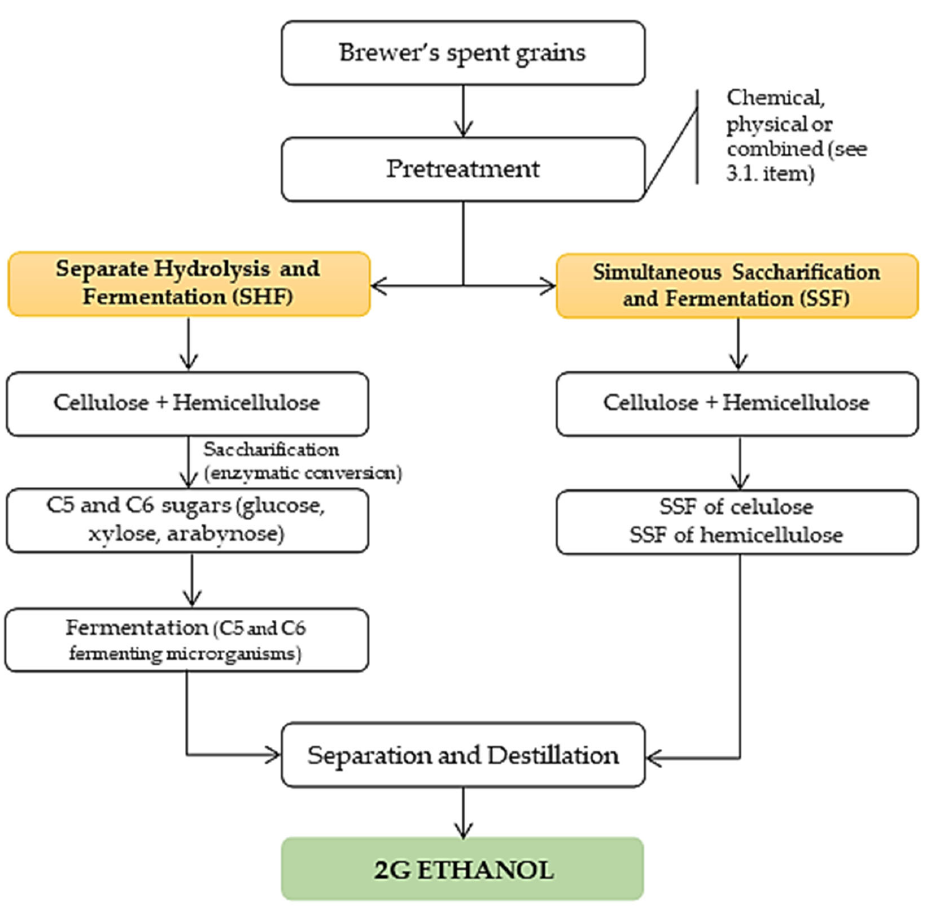
Figure 5. General process for obtaining 2G ethanol using the holocellulosic portion from BSG.